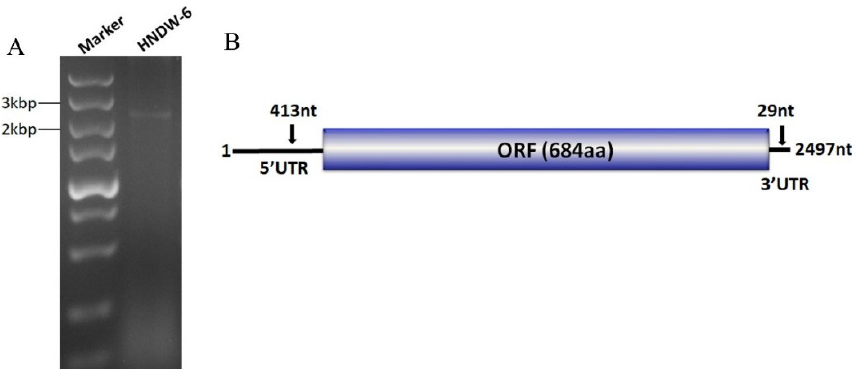
Figure 1. Agarose gel electrophoresis analysis of the dsRNA extracted from the Magnaporthe oryzae strain HNDW-6 and the genome organization of MOLV4. ( A ) dsRNA pattern of strain HNDW-6 was observed on 1% agarose gel, with the size estimated with a DNA marker. ( B ) Schematic representation of the genome of MOLV4, which contained a single open reading frame (ORF) putatively encoding the RNA-dependent RNA polymerase (RdRp) and the 5’and 3’ untranslated regions (UTRs).